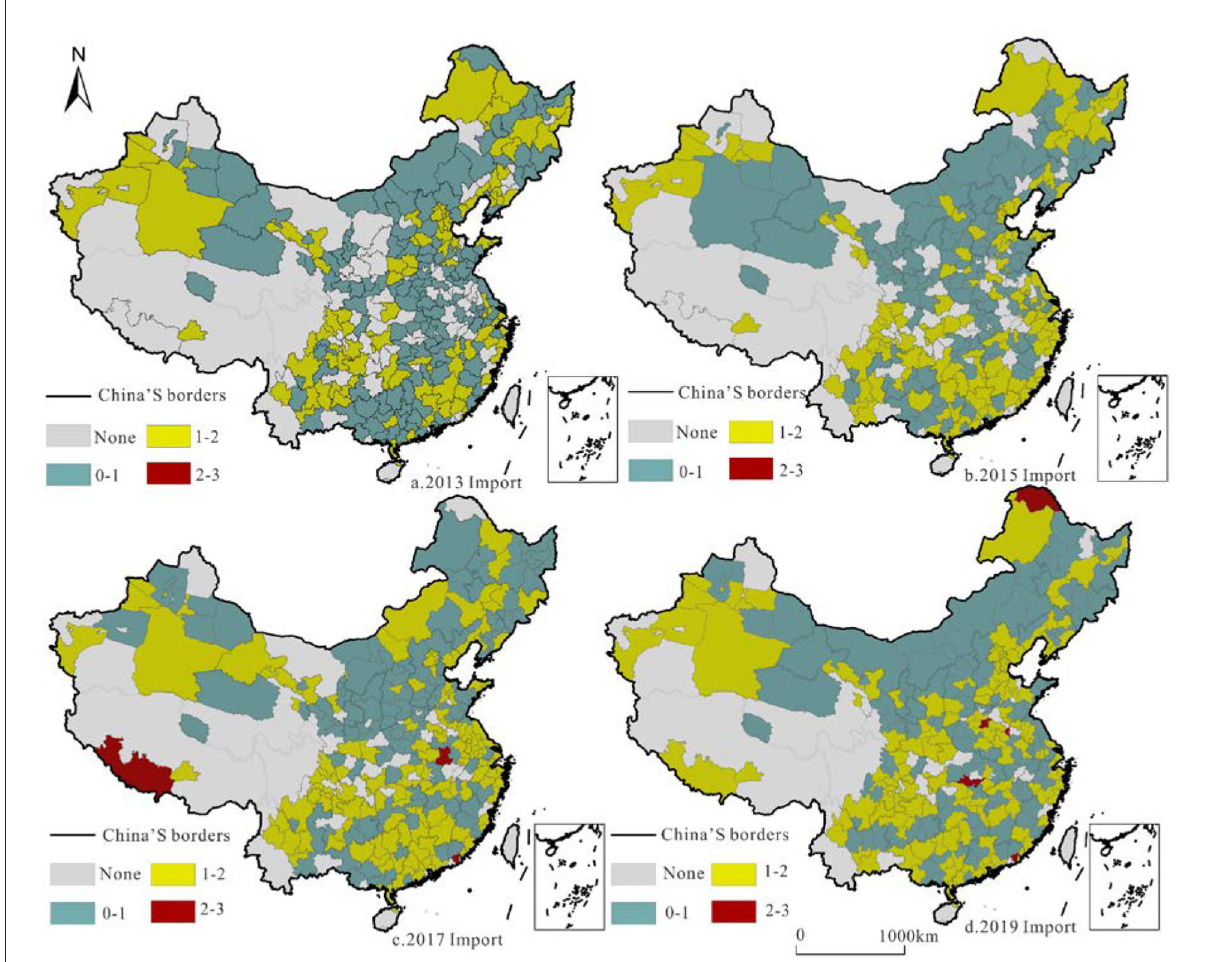
FIGURE10 Location quotient pattern and evolution of China’s railway container export volume in